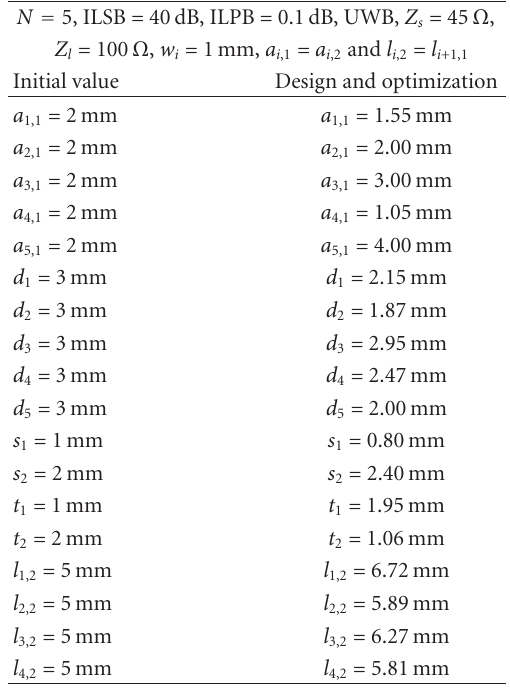
Figure 4: Schematic of the proposed multilayered microstrip hairpin filter. Table 2: Parameters of designed proposed multilayered microstrip hairpin filter (Example